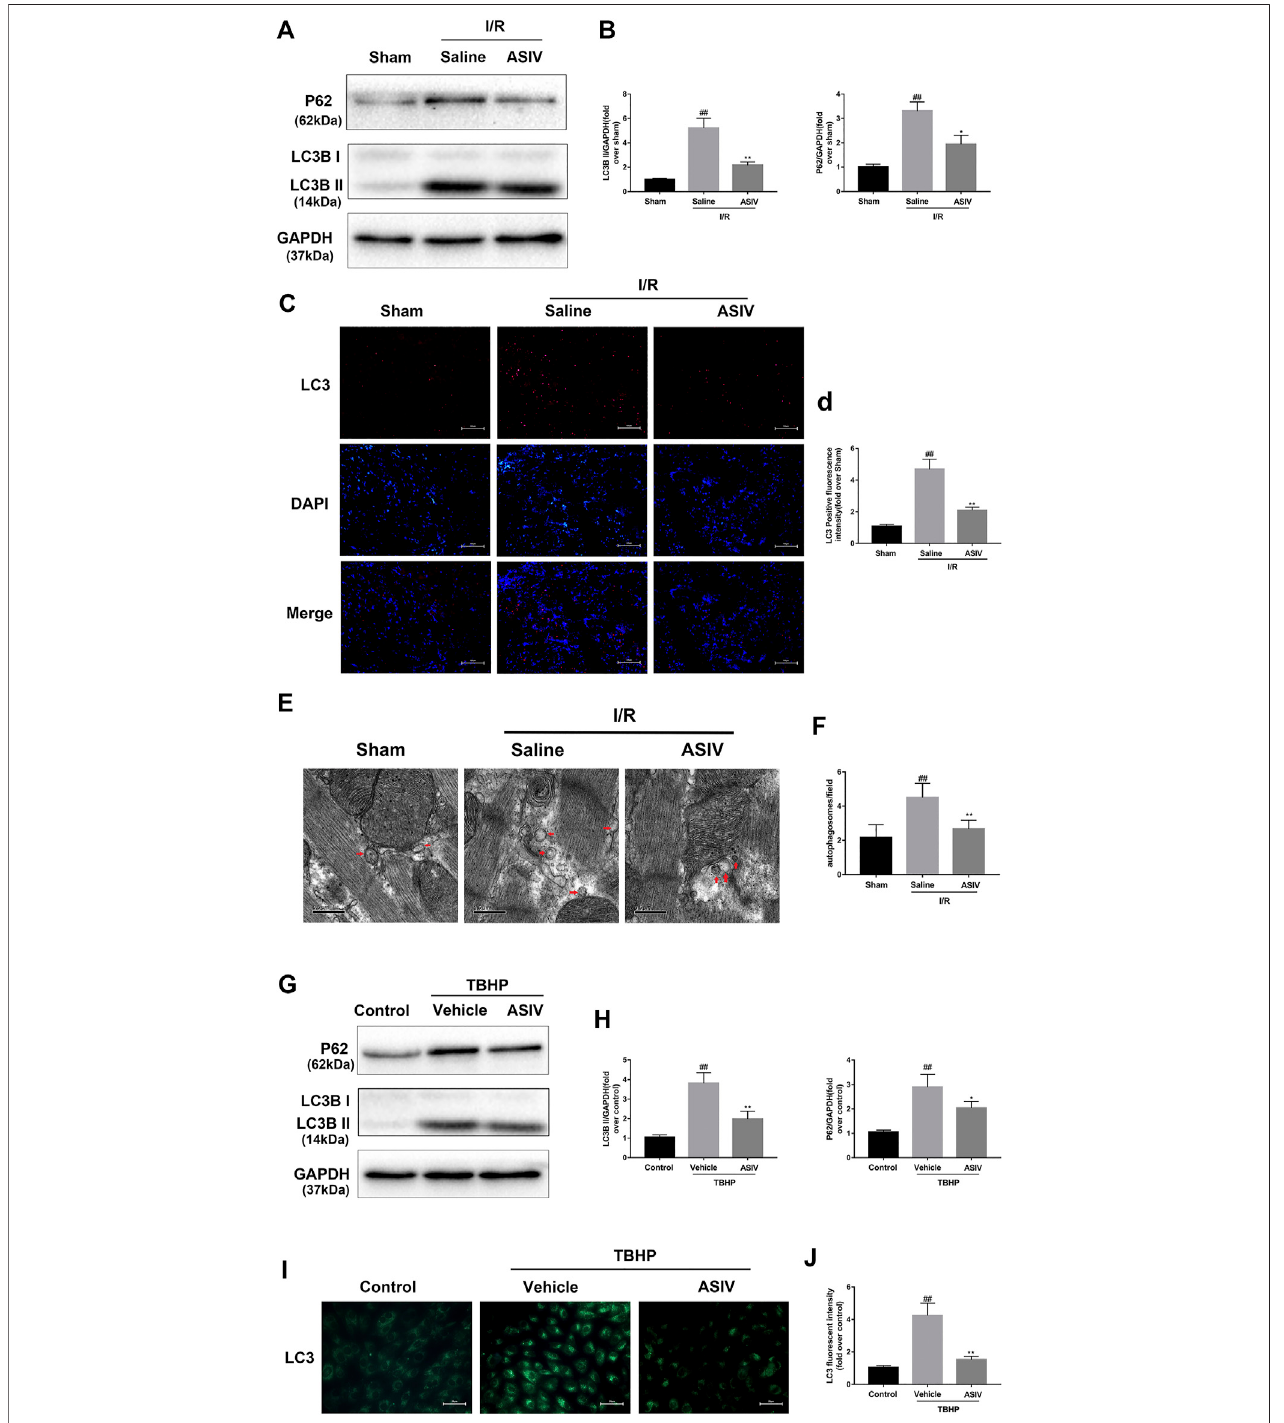
FIGURE 3 | ASIV attenuated I/R-induced autophagosome accumulation. In I/R induced mice hearts after various treatment, (A, B) protein expression levels of LC3B and P62 were analyzed by western blot. (C, D) Autophagosomes (red) in cells in the Sham, I/R and ASIV groups by Immuno fl uorescence staining for LC3 .Scale bar:100 µm. After H9C2 cells were treated with ASIV and suffered from TBHP injury, (E, F) Transmission electron micrographs of LV tissue sections. Transmission electron micrographs ( × 17,000) of the myocardium showing autophagosomes surrounded by double membranes (arrows). (G, H) protein expression levels of LC3B and P62 were analyzed by western blot. (I, J) Representative immuno fl uorescence images of H9C2 loaded with LC3. The autophagosomes of cells was determined. Scale bar:25 μ m n (cid:2) 6. Values are expressed as the means ± SD. # p < 0.05 compared with the sham or control group, * p < 0.05 compared with the I/R or TBHP group (each test was repeated three